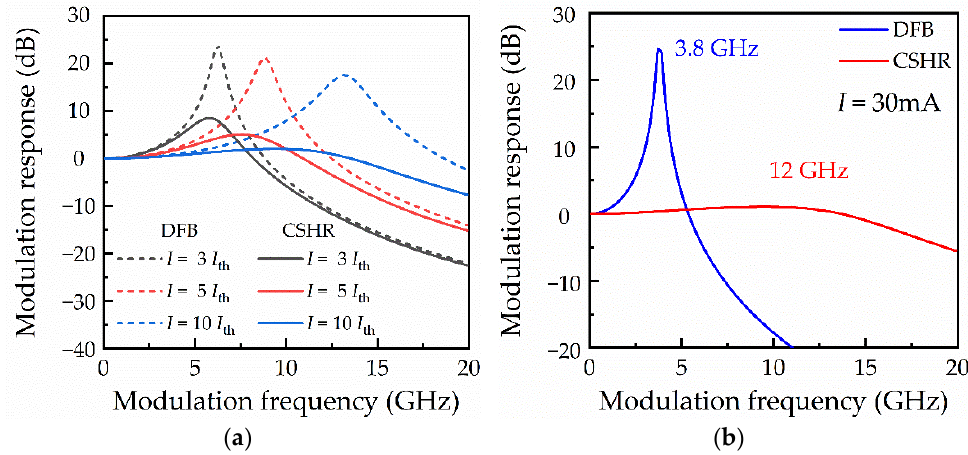
Figure 2. The small signal modulation response curves of DFB laser and CSHR microlaser. ( a ) under different bias currents; ( b ) under the same current.